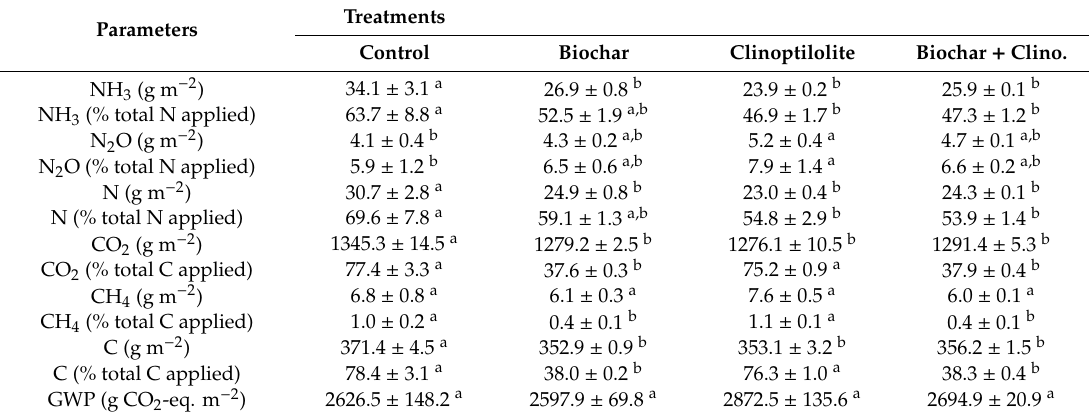
Table 3. Cumulative gaseous emissions from each treatment (mean ± standard deviation) ( n = 3).